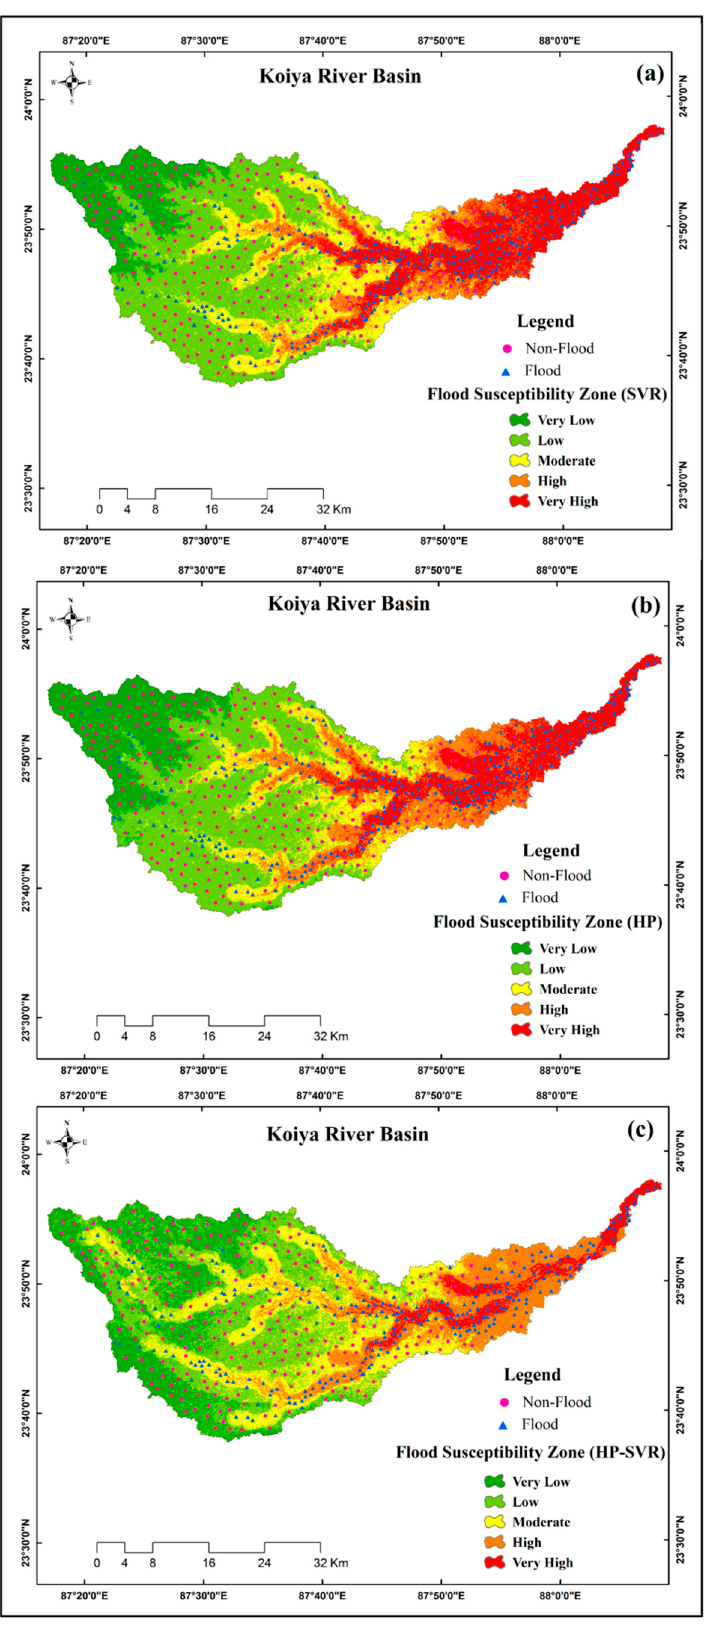
Figure 6. Flood susceptibility mapping by using machine learning (ML) algorithms of ( a ) support vector regression (SVR), ( b ) hyperpipes (HP) and ( c ) HP-SVR